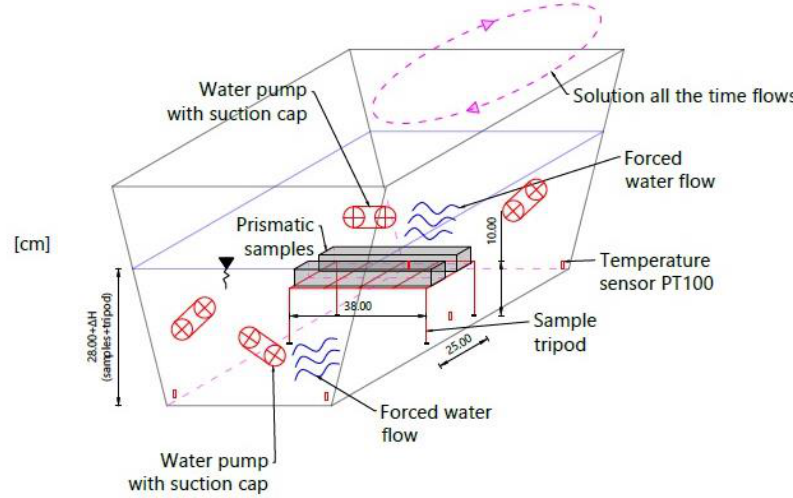
Figure 4. Experimental brine soaking pattern [11].